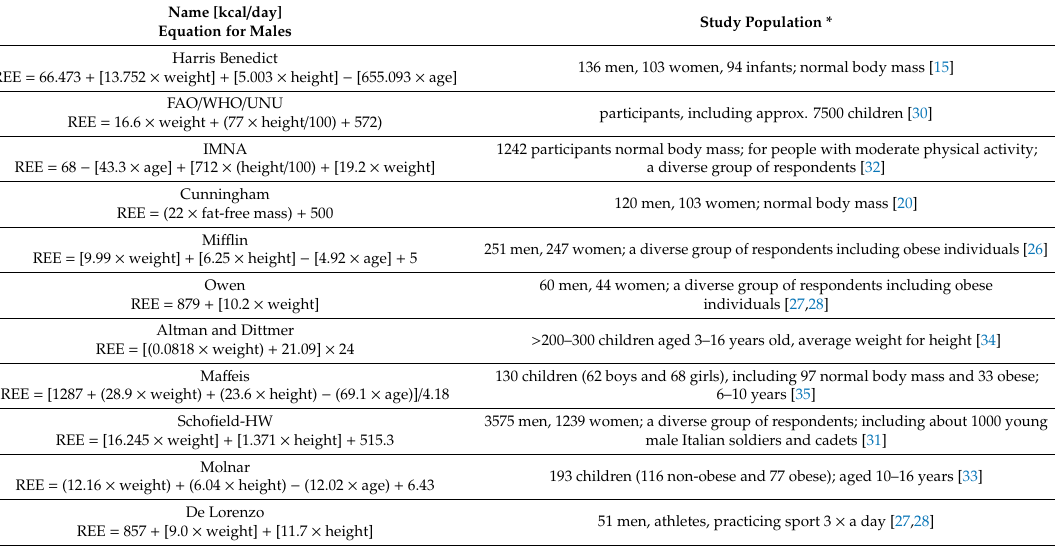
Table 4. Equations evaluated in the